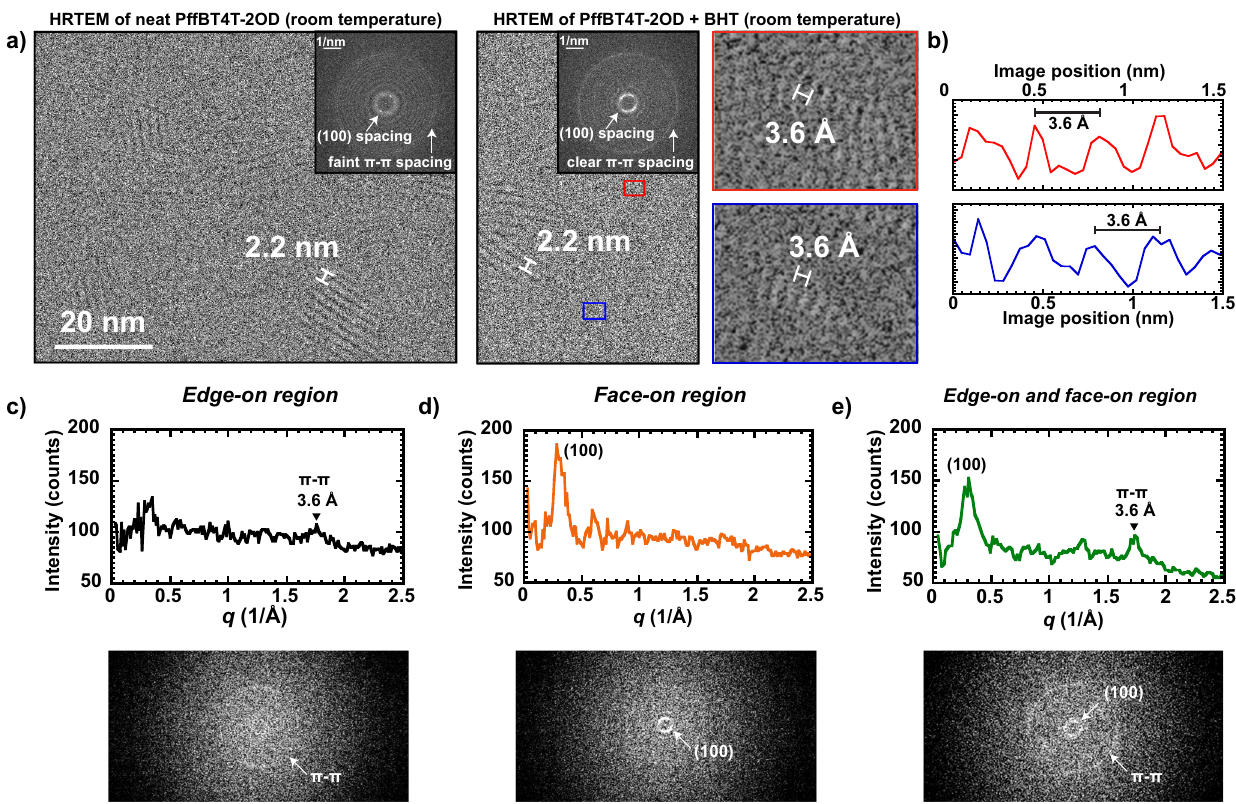
Fig. 3 HRTEM at room temperature of PffBT4T-2OD without and with the addition of BHT. Without BHT, the 2.2 nm (100) lattice fringes can be seen, but π – π stacking remains elusive. With the addition of BHT, a clear π - π stacking ring is visible in the FFT, and Fourier fi ltering the image reveals 3.6 Å π – π stacks. Dose of HRTEM images is 10 e/Å 2